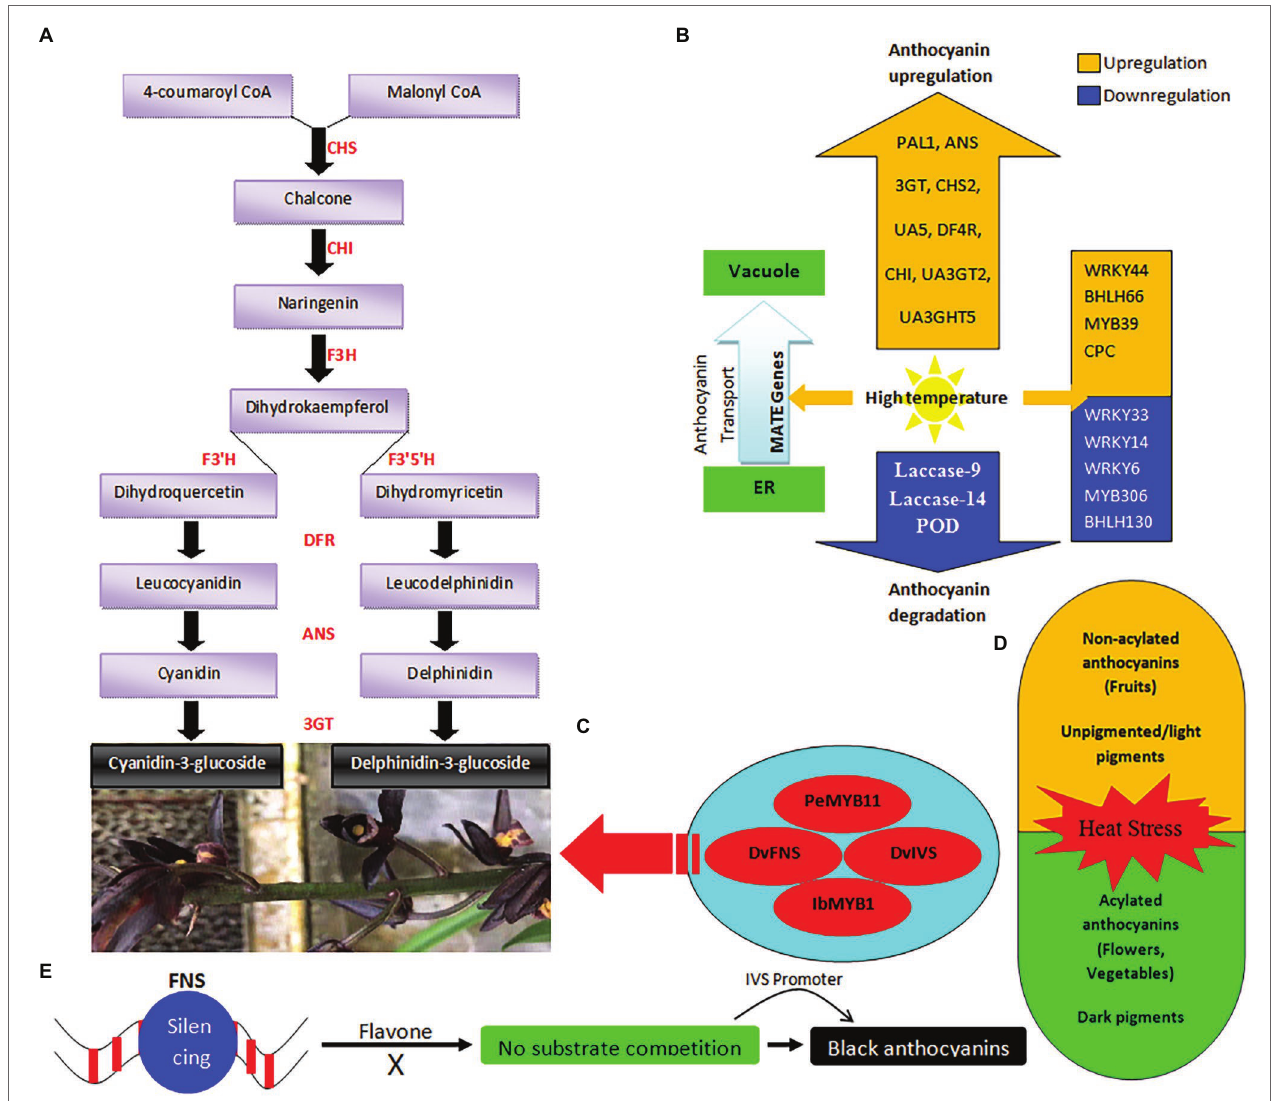
FIGURE 1 | Summary of black color anthocyanin accumulation pathways (A) ; effect of high temperature on molecular regulation of deep color anthocyanins (B) ; the key genetic regulators of black color anthocyanin accumulation in the flower petals (C) ; the common effects of heat stress on plant anthocyanins (orange color shows more susceptibility towards heat stress and the green color shows stability towards heat stress; D ); and the proposed pathway of black anthocyanin generation through induced gene silencing (E)